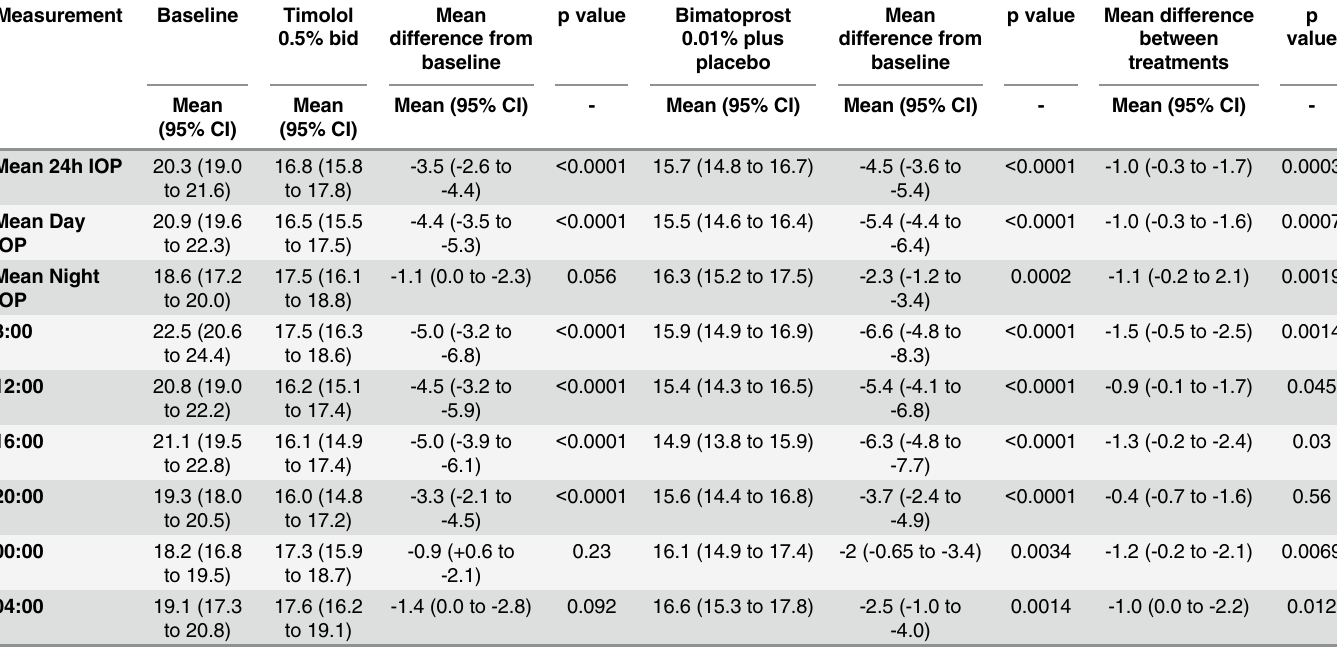
Table 1. Comparison of mean intraocular pressure (mmHg) at baseline and after treatment with bimatoprost 0.01% once at night and after timolol 0.5% bid.